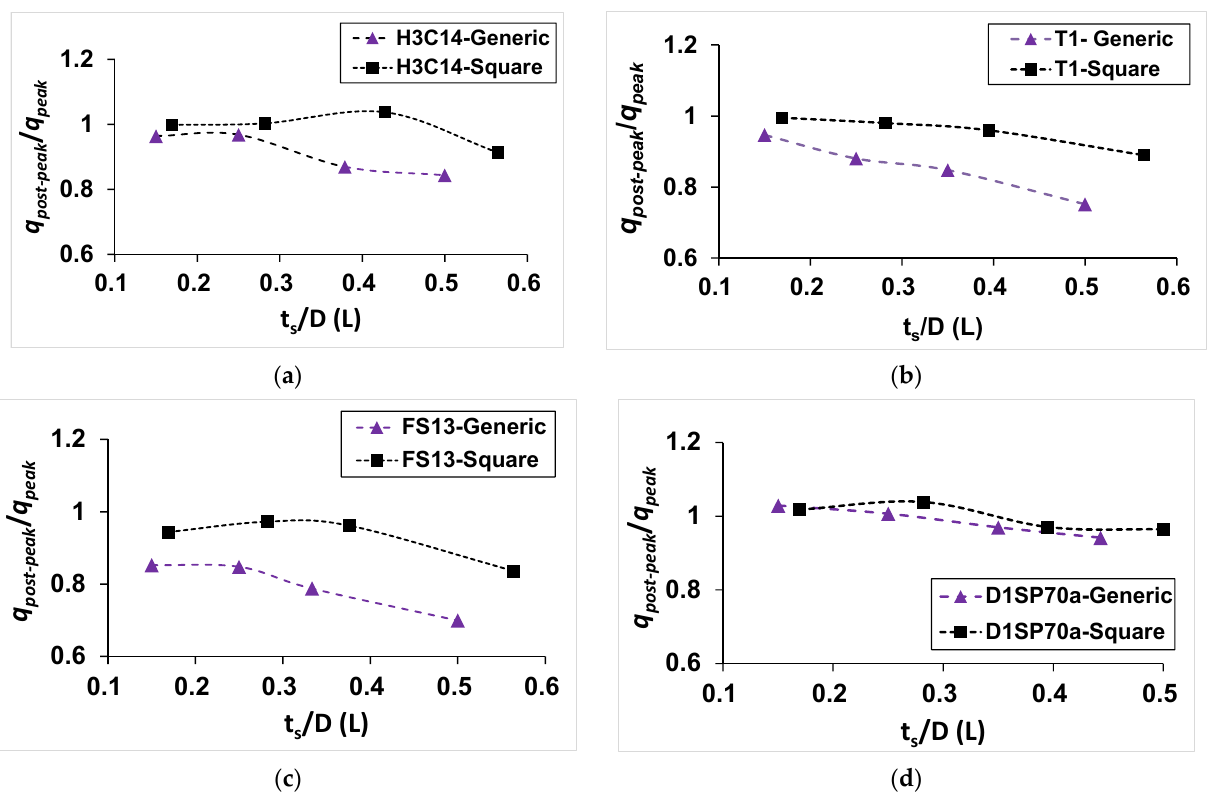
Figure 7. Effect of sand layer thickness on q post-peak / q peak : ( a ) test H3C14; ( b ) test T1; ( c ) test FS13; and ( d ) test D1SP70a.